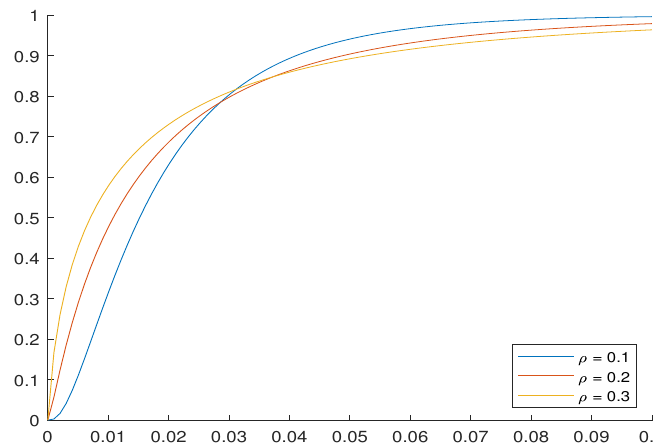
Figure 2. Unconditional cumulative probabilities of default for a default probability of p = 0.02 and different values of asset correlation ρ